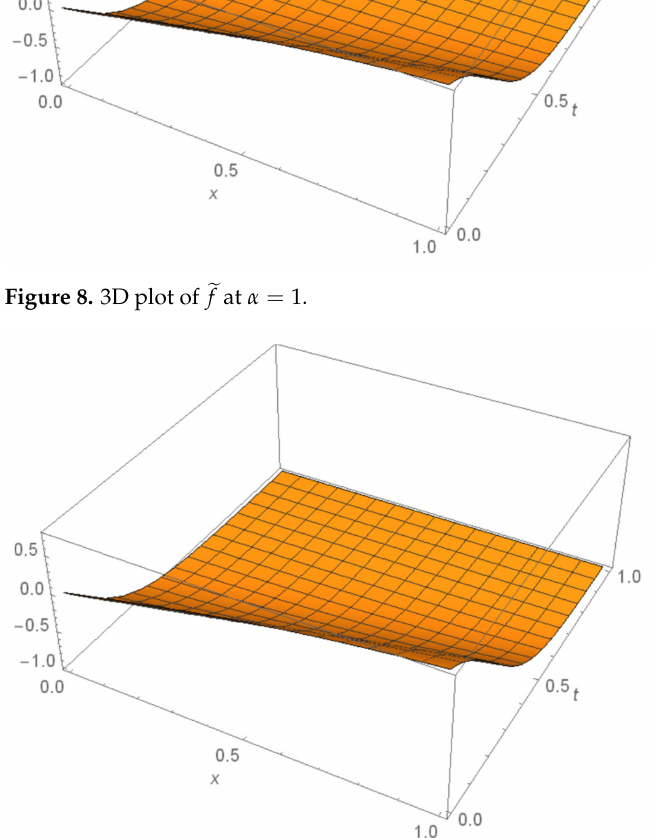
Figure 9. 3D plot of exact solution of f .